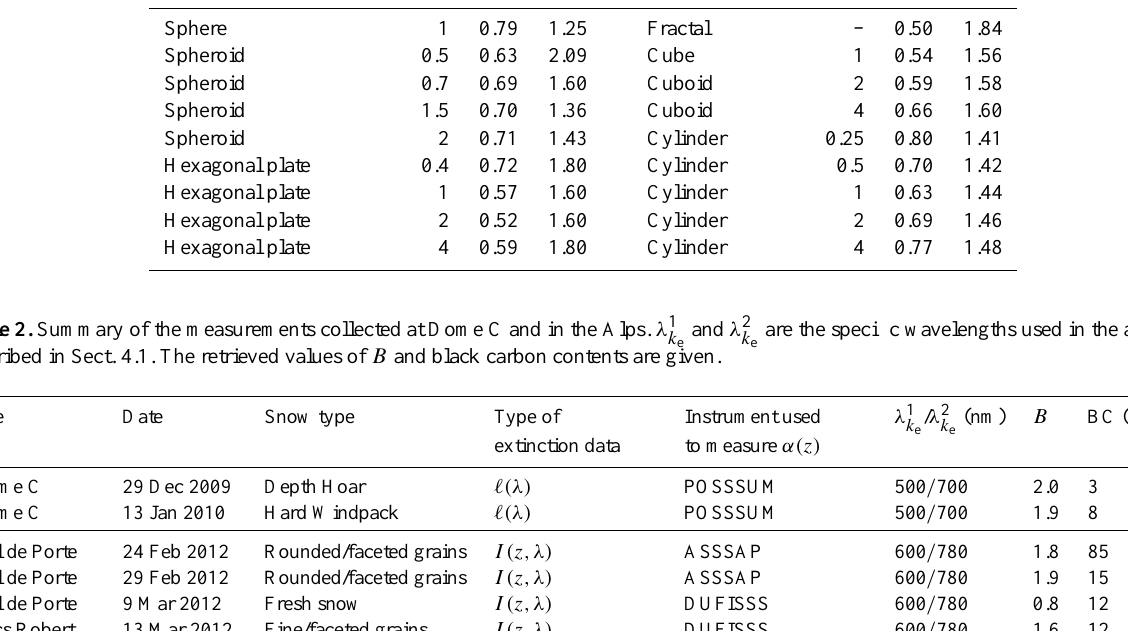
Table 1. Values of B and g G for various geometric shapes, computed using ray tracing methods. Values for spheroids, hexagonal plates and fractals are taken from Kokhanovsky and Macke (1997) and were obtained with a complex refractive index m = 1 . 33. The value for fractal is from Kokhanovsky and Zege (2004) and was obtained at m = 1 . 31 − 10 − 7 i . The values for the other shapes were obtained with SnowRat (Picard et al., 2009) at m = 1 . 30 − 4 . 2 × 10 − 7 i (which is the ice refractive index at 900nm). For hexagonal plates, cuboids and cylinders, the aspect ratio is the ratio of the height to, the length of the hexagonal side, the length of the square side and the radius of the circle, respectively. For spheroids, it is the ratio of the largest semi-axis to the shortest one.